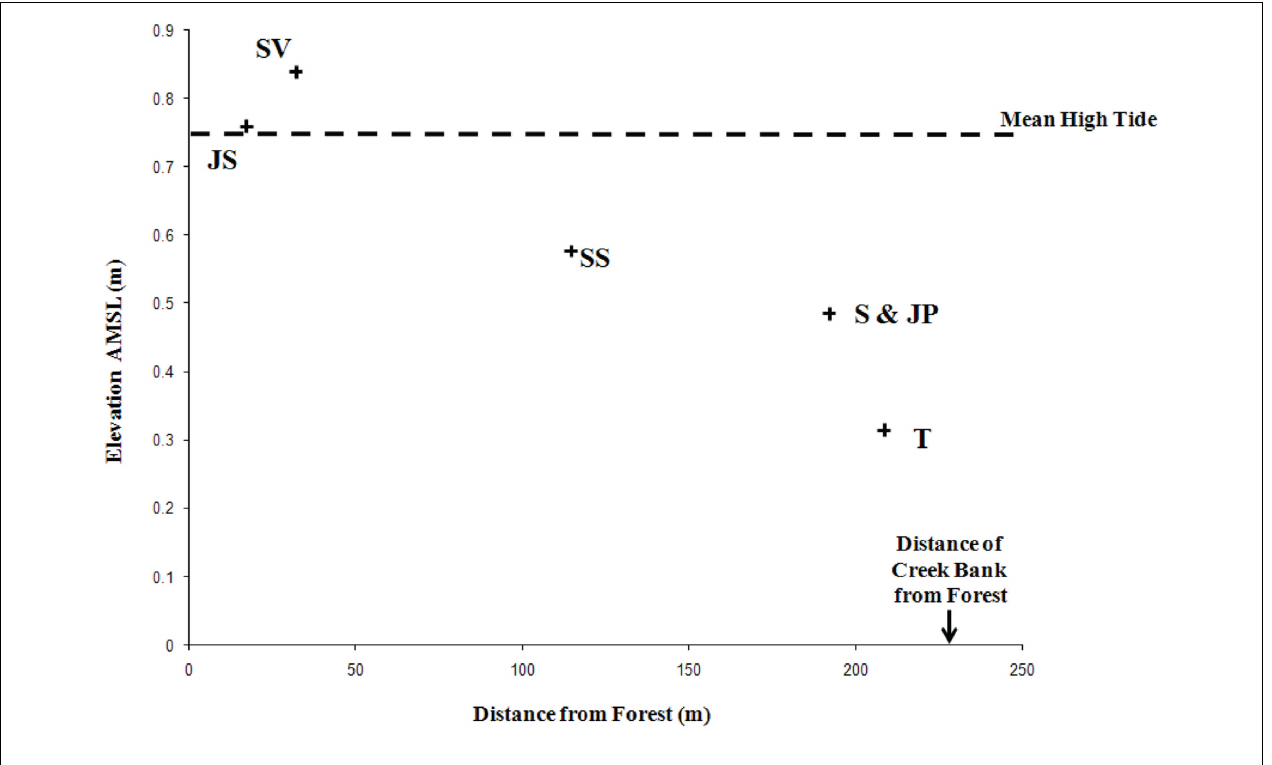
FIGURE 1 | Differences in site elevation above mean sea level (AMSL) and distance of each sampling location from the forest edge. Site designations: Juncus roemerianus stand (JS); Salicornia virginica (SV); mixed plant zone of co-occurring S. virginica and